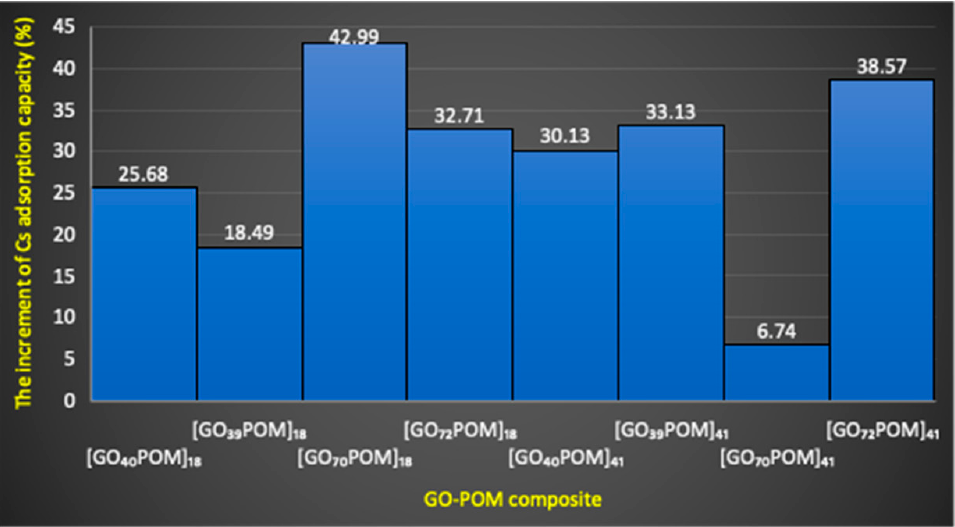
Figure 6. The increment of Cs adsorption capacity (%) calculated by using the ratio before and after forming a composite in each GO